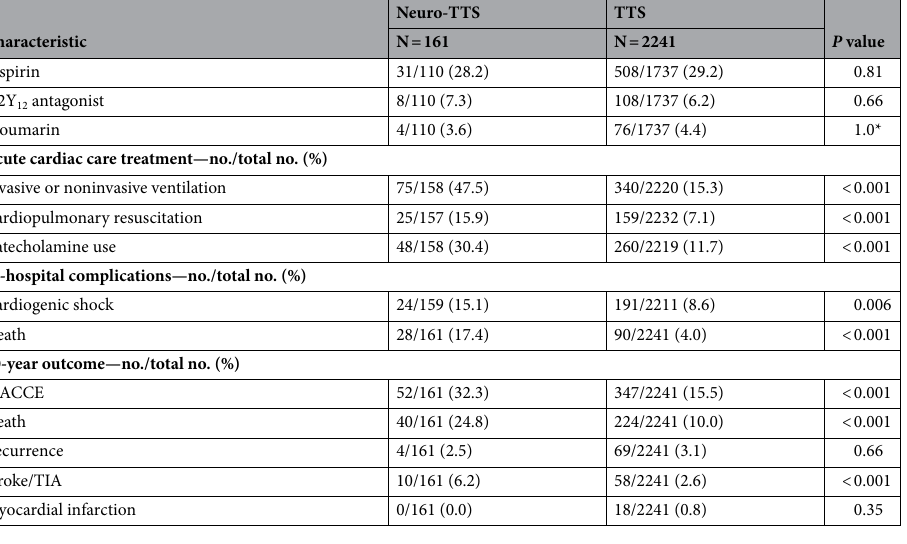
Table 1. Characteristics of Takotsubo patients. ACE Angiotensin-converting-enzyme, ARB Angiotensin- receptor blocker, BNP Brain natriuretic peptide, COPD Chronic obstructive pulmonary disease, CRP c-reactive protein, ECG Electrocardiogram, IQR Interquartile range, MACCE major adverse cardiac and cerebrovascular event, QTc QT interval corrected for heart rate, SD Standard deviation, TIA transient ischemic attack, TTS Takotsubo syndrome, ULN Upper limit of the normal, WBC white blood cell count. °Including upper limits of the normal range for troponin T, high-sensitivity troponin T, and troponin I. † Including upper limits of the normal range for brain natriuretic peptide and the N-terminal of prohormone brain natriuretic peptide. ‡ Data obtained during catheterization or echocardiography if both results were available data from catheterization were used. *Fisher’s exact test.